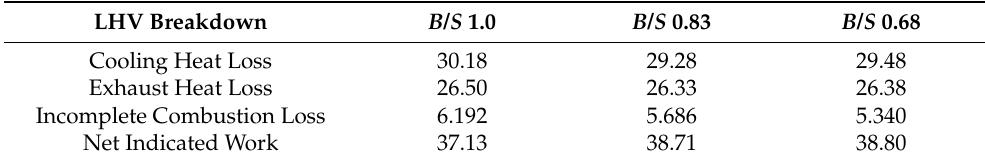
Table 3. LHV breakdown for different S / B ratios at 2000 rpm, λ = 1 and 26 mg/cycle of fuel mass supplied to the engine adapted from ref.